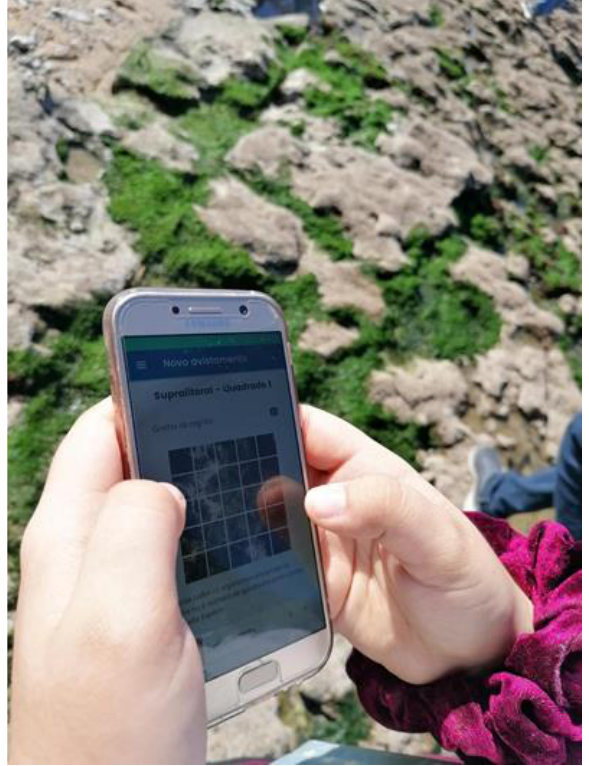
Figure 6. Educational program “Roteiro -entre- marés” app regarding seaweeds natural occurrence.